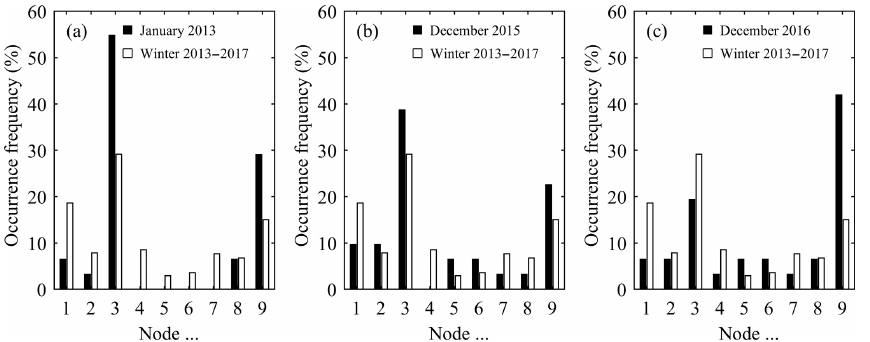
Figure 8. Occurrence frequency of the ABL types (i.e., SOM nodes) during (a) January 2013, (b) December 2015 and (c) December 2016. The winter-averaged frequency during the 5-year (2013–2017) period is repeated on each plot for comparison. Table 1. Estimated contribution of ABL anomaly to elevated PM 2 . 5 concentration in January 2013, December 2015 and December 2016. Pollution Monthly averaged PM 2 . 5 Total anomaly C (cid:48) ABL-driven anomaly Contribution ratio of month concentration (µgm − 3 ) (µgm − 3 ) C ABL’ (µgm − 3 ) ABL-driven anomaly (%) January 2013 180.1 76.1 44.4 58.3 December 2015 151.8 47.8 22.2 46.4 December 2016 151.2 47.2 34.6